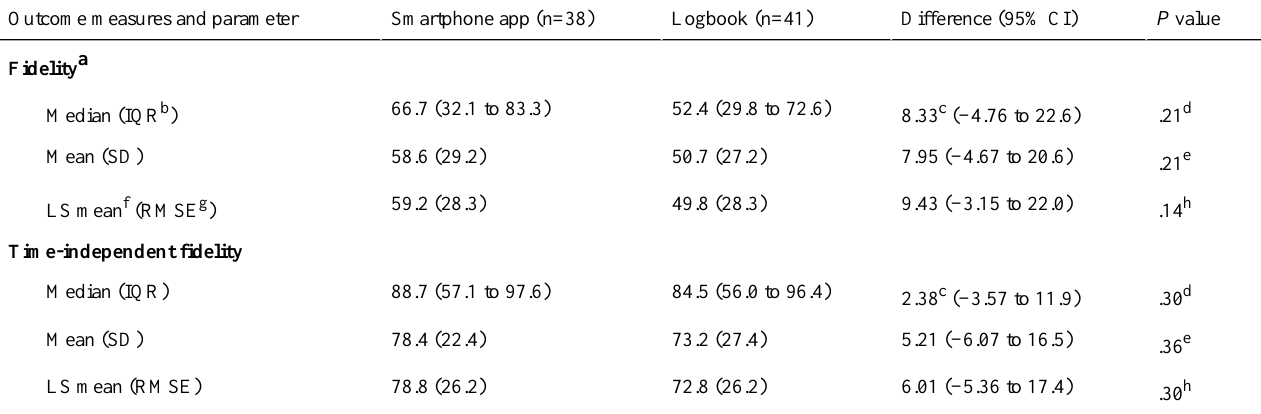
Table 2. Comparison of home blood pressure recording fidelity in all